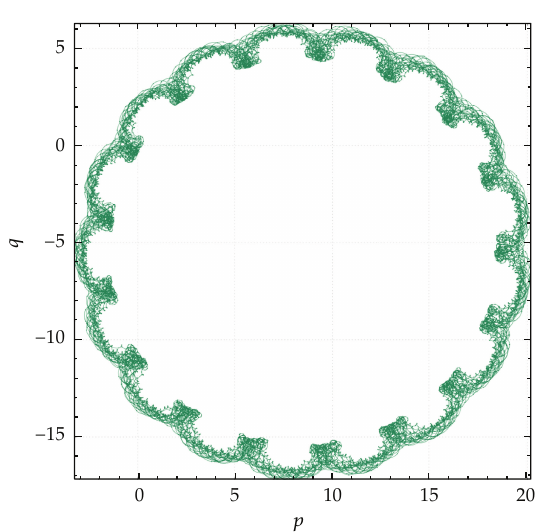
Figure 2: A regular orbit at E (cid:7) 0 . 166666 on the (cid:5) p,q (cid:6) -plane.